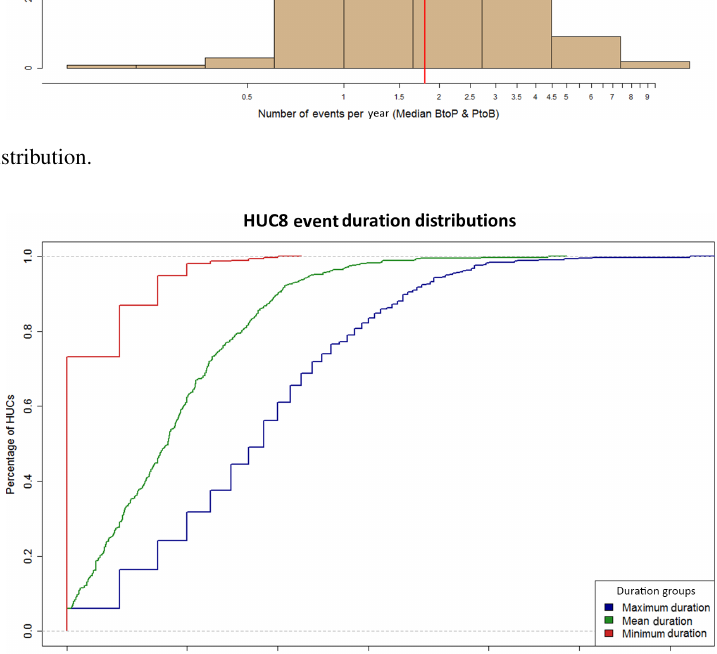
Figure 8. HUC8 event duration